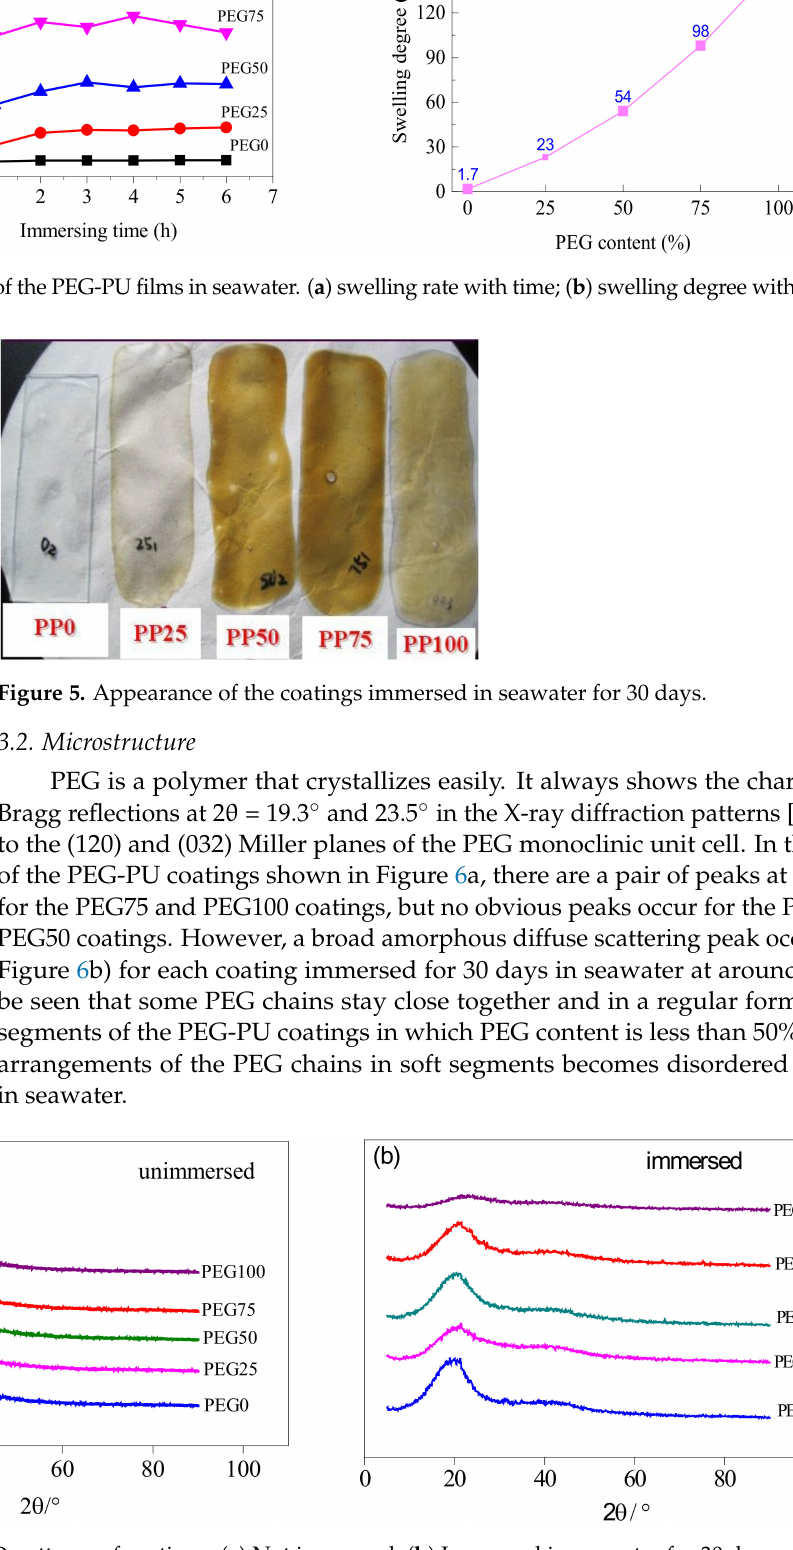
Figure 6. XRD patterns of coatings. ( a ) Not immersed; ( b ) Immersed in seawater for 30